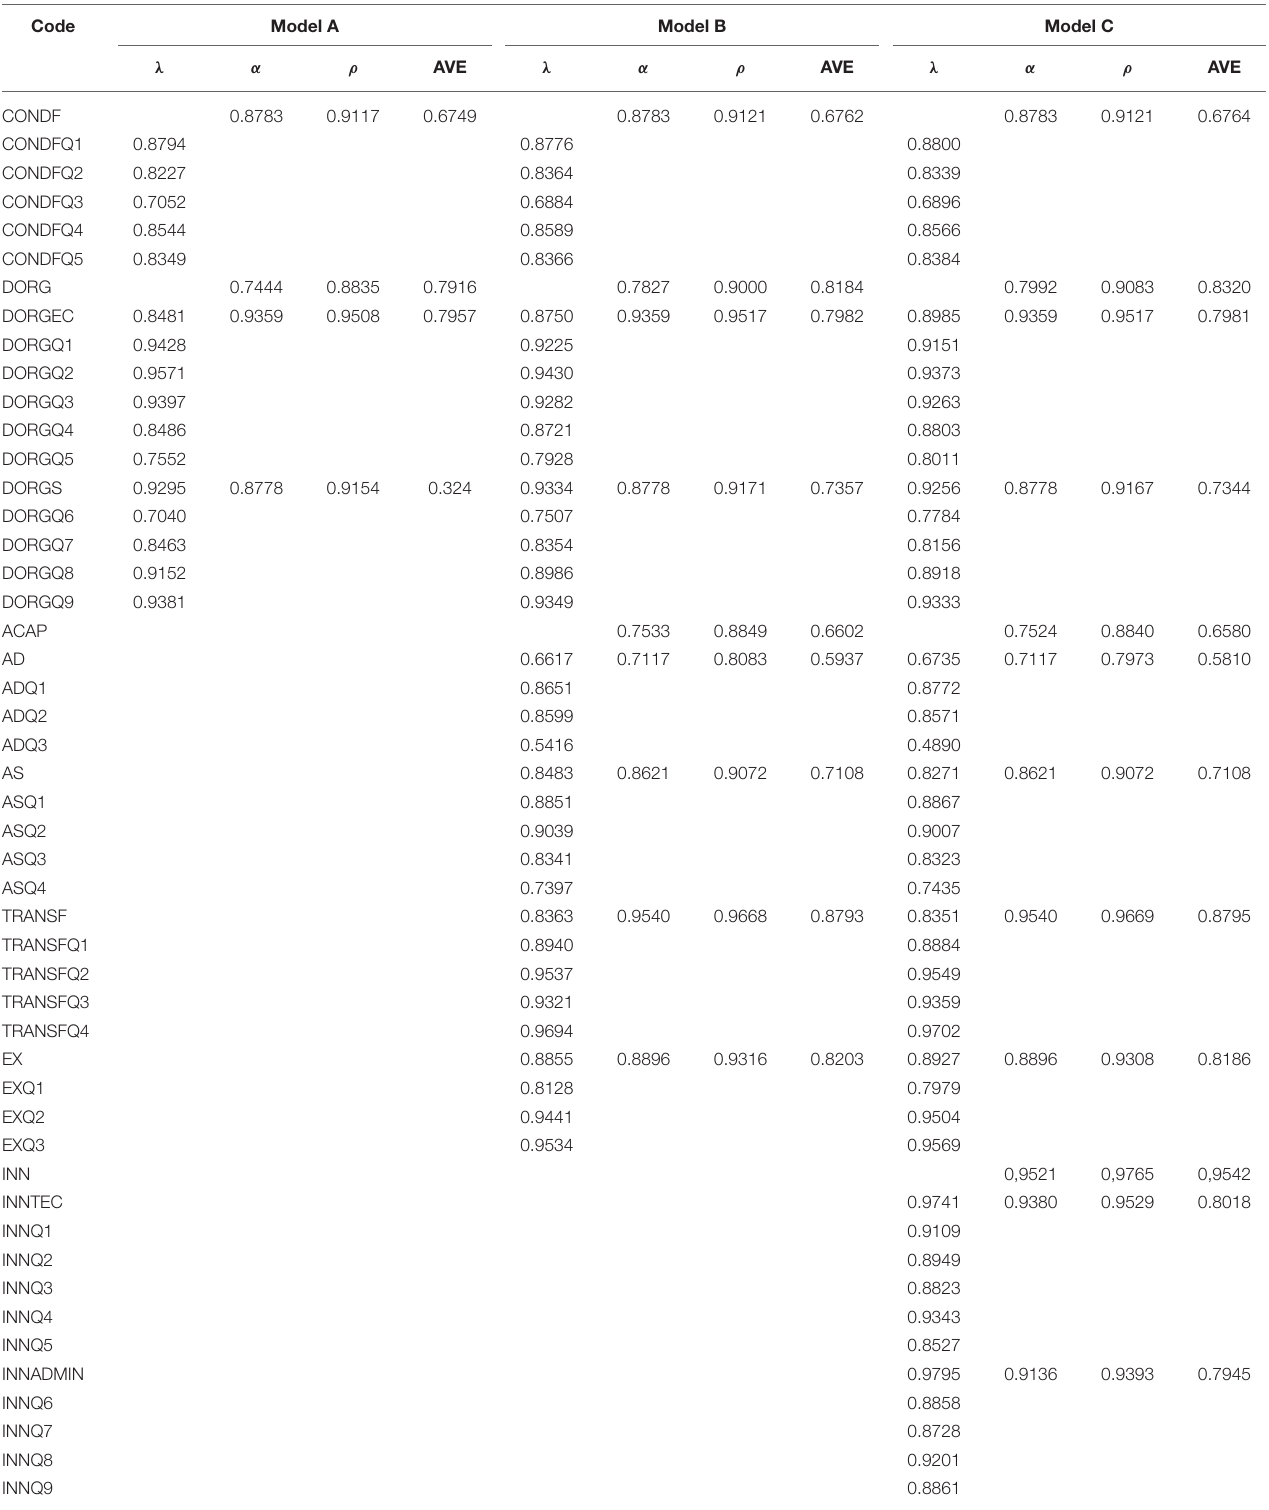
TABLE 3 | Overview of survey items: loadings, construct reliability and convergent validity for the measurement models.